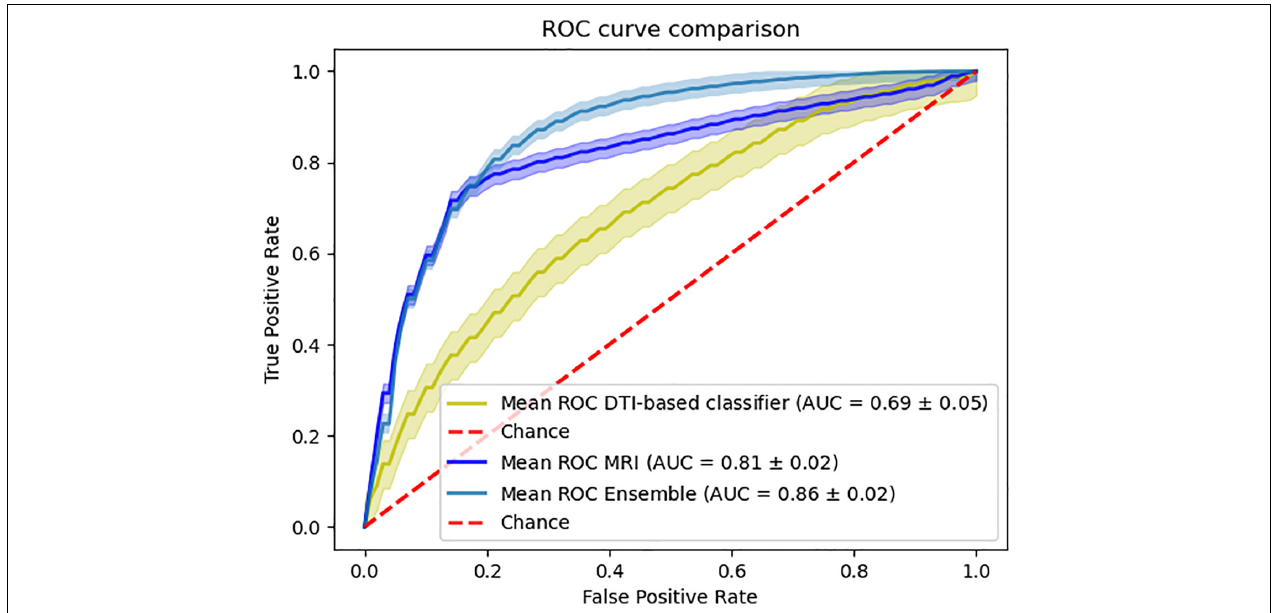
FIGURE 4 | Ensemble results of combining MRI and DTI data. Comparison of the ROC curve of the classifiers using the external